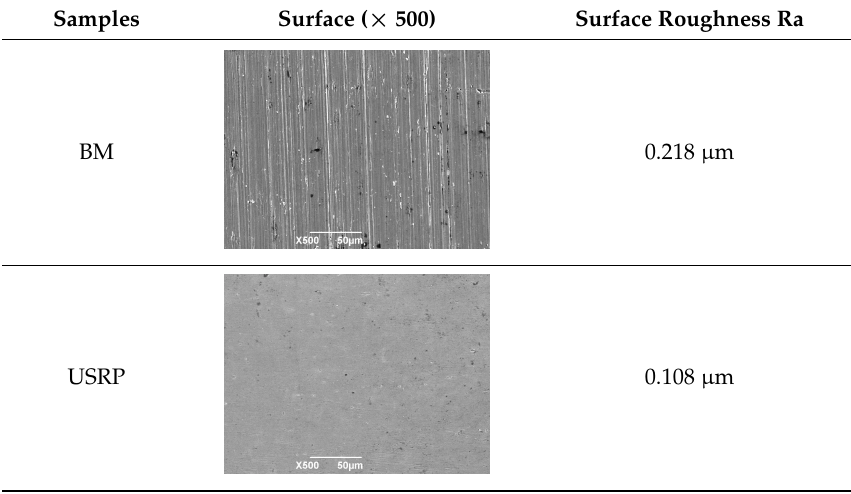
Table 2. The surface morphologies and surface roughness (Ra) of BM and USRP samples.